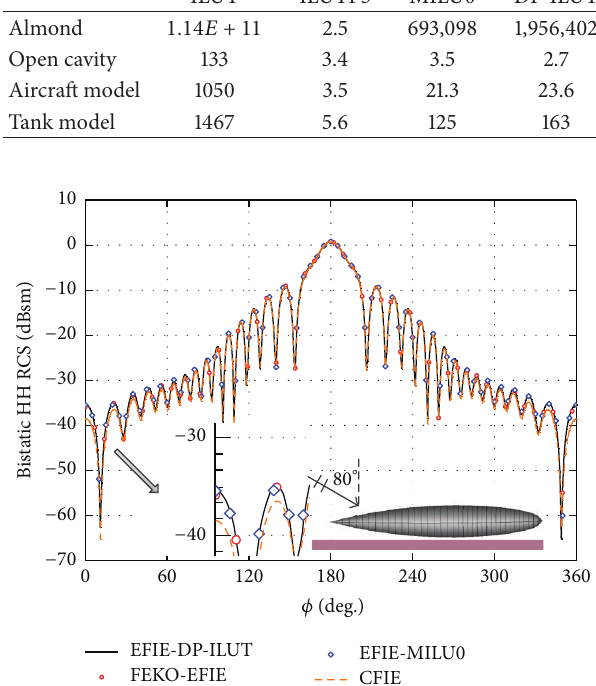
Figure 3: The H-polarized bistatic RCS patterns of an almond shape above the half space in the 𝜃 = 80 ∘ cut at 9 GHz.